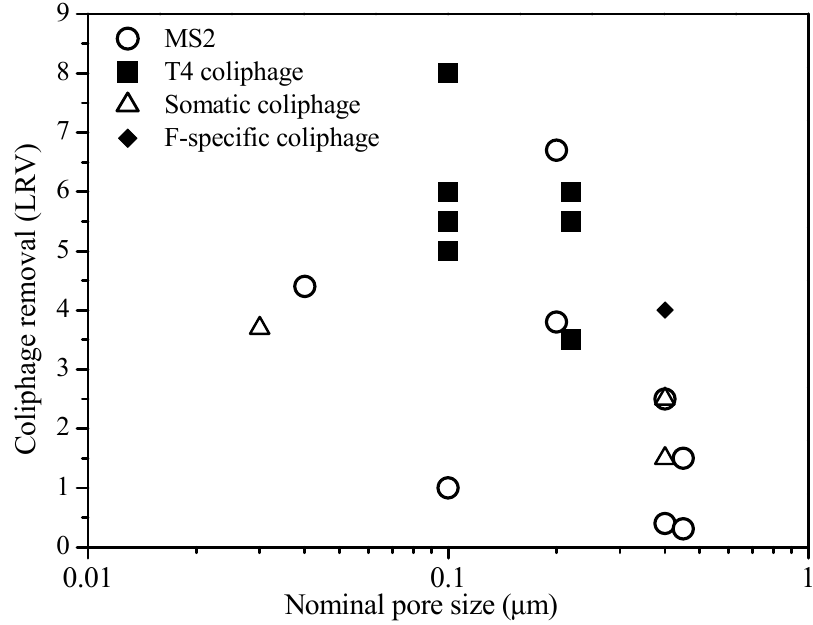
Figure 2. Virus Removal as a function of membrane pore size in bench and